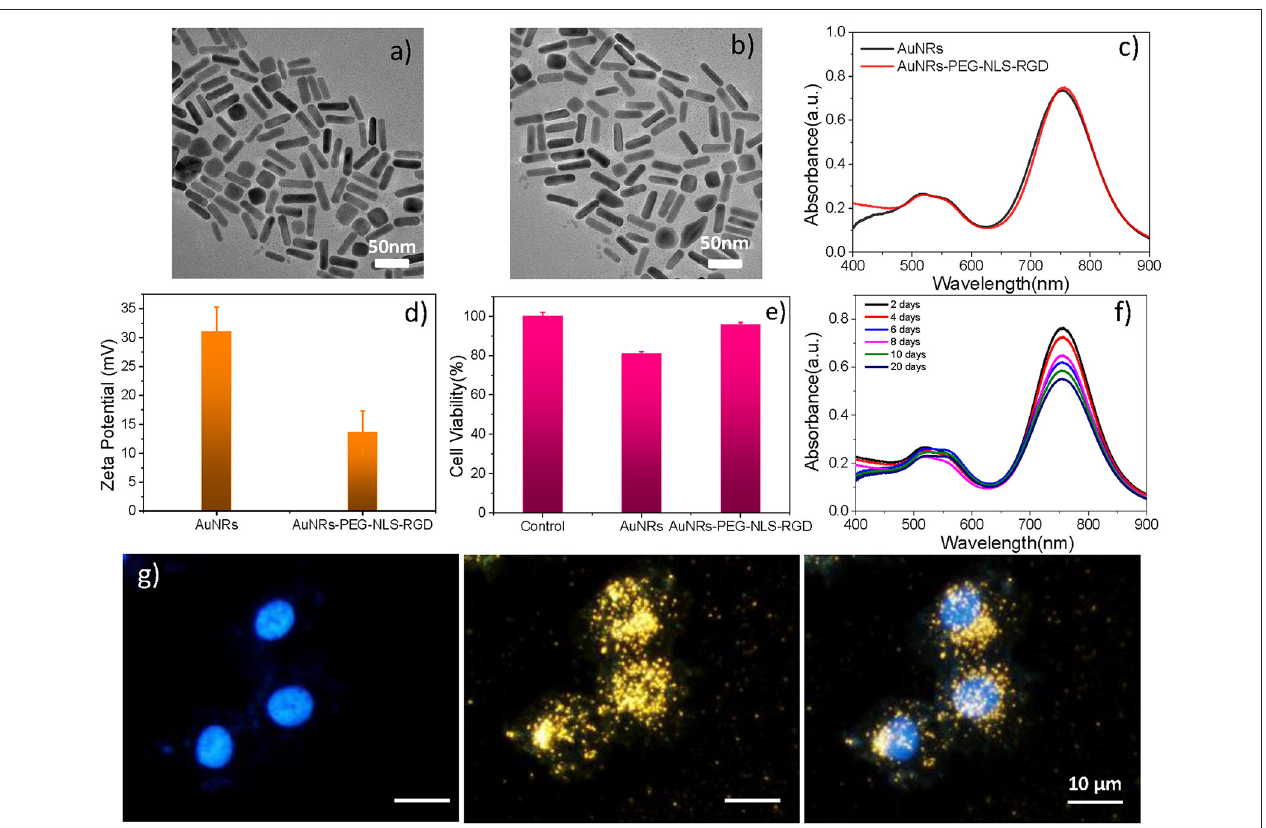
FIGURE 2 | A TEM image of (a) AuNRs and (b) AuNRs-PEG-NLS-RGD. (c) UV–vis spectra of AuNRs and AuNRs-PEG-NLS-RGD. (d) Zeta potential of AuNRs and AuNRs-PEG-NLS-RGD. (e) Cell viabilities of B16 cells incubated with 0.1nM of AuNRs and AuNRs-PEG-NLS-RGD for 24h. (f) Uv-vis spectra of AuNRs-PEG-NLS-RGD nanoprobes after storage at 4 ◦ C for 20 days. (g) Fluorescent, dark-field and merged images of B16 cells incubated with AuNRs-PEG-NLS-RGD for 12h from left to